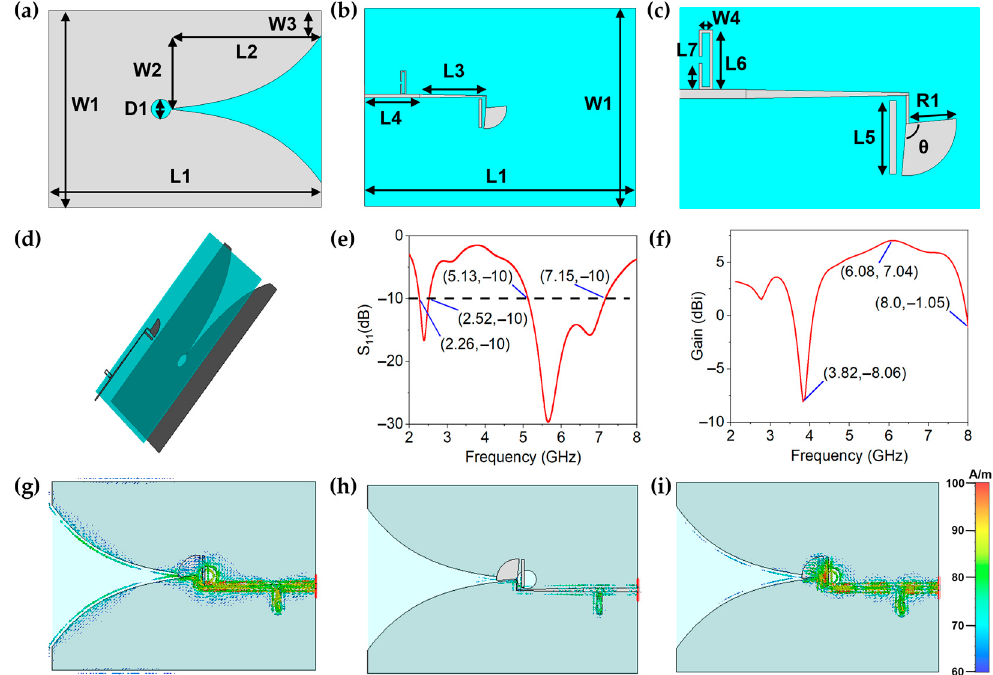
Figure 2. ( a – d ) Structure of the proposed flexible GAF dual-band antenna. ( a ) Top view. ( b ) Bottom view. ( c ) The model of feed structure. ( d ) Perspective view. ( e ) Simulated reflection coefficients of the GAF antenna under flat state. ( f ) Simulated gain of the GAF antenna under flat state. ( g – i ) Surface current distributions of the GAF antenna at 2.45 GHz, 3.8 GHz and 8 GHz.